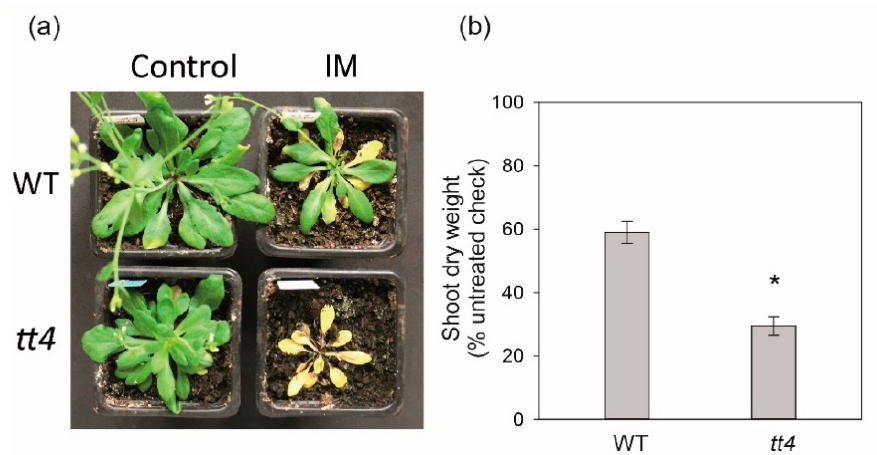
Figure 8. TT4 function for the rate-limiting step into flavonol production is necessary for A. thaliana tolerance to low herbicide dose. ( a ) Visual effect, ( b ) shoot dry weight of A. thaliana wild type (WT) and tt4 mutant 14 days after application of imazethapyr (IM). Error bars indicate the standard deviation of four biological replicates, statistically significant differences relative to WT is indicated by asterisk ( t -test, p ≤ 0.05); * compared to WT.